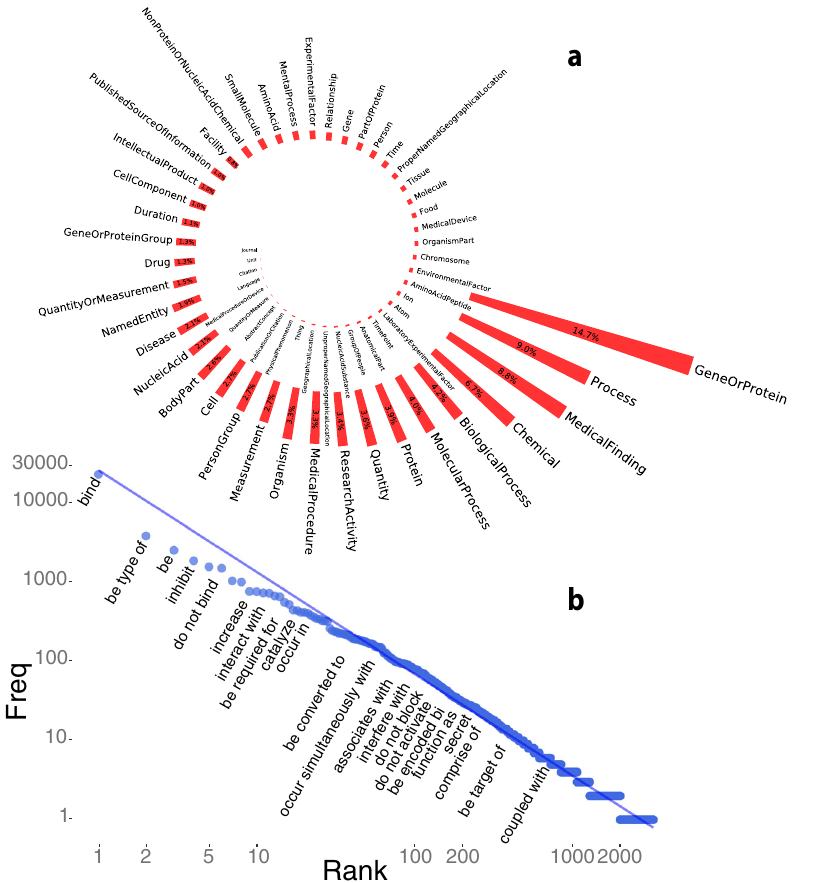
Fig. 2 The relative abundance of annotated named entity classes in our corpus. As is typically the case with human languages, semantic classes are represented unevenly in free texts, following a heavy-tail (Zipf ’ s) distribution. a In biomedical corpora, unsurprisingly, named entities associated with genes and proteins are the most prevalent (15%), followed by processes (9%), medical fi ndings (8.8%), and chemicals (6.7%). At the low-frequency end of the named entity spectrum, we fi nd journal names , units , citations , and languages . b Events connecting two or more entities are also approximately Zipf-law distributed. Event frequencies are closely tracking corresponding named entity classes. For example, the most frequent event, bind , is associated with the most frequently named entity, GeneOrProtein . We tried fi tting the rank-ordered frequency distribution of annotated named entities with a Discrete Generalized Beta Distribution (DGBD). The result showed a signi fi cant deviation from Zipf ’ s law 33 : The observed distribution ’ s tail was not heavy enough to match Zipf ’ s distribution, most likely due to the relatively small number of classes in our ontology 34 . In other words, we expect that frequencies of semantic classes in a very large corpus, annotated with classes from a hypothetical perfect named entity ontology, would follow a Zip fi an (discrete Pareto) distribution of named entity classes. Our action annotations have moved beyond interactions between proteins and genes ( e.g ., bind , inhibit , phosphorylate , encode ), into interactions involving genetic variants and environmental factors ( e.g ., associated with , occur in presence of , trigger , lack ). Ambiguity levels varied broadly across the named entities captured in our corpus. For example, in the class AnatomicalPart , almost all (99.3%) are annotated at the most speci fi c levels, with the majority of entities belonging to BodyPart , CellularComponent , and Cell . In contrast, the general (most vague) concept, Chemical , turns out to be the most annotated within its cluster, although more speci fi c subclasses, such as Protein , NucleicAcid , and Drug are also well represented in the corpus. In the Process concept cluster, about a third of all concept instances are annotated at a more general Process level, and the rest of them are speci fi c concepts, such as MedicalProcedure , MolecularProcess , ResearchActivity , and BiologicalProcess . In addition to these major clusters of concepts, several individual concepts are well represented in the corpus. For example, MedicalFinding represents 7.3% of all entities. Other well-represented concepts include Duration , IntellectualProduct , Measurement , Organism , PersonGroup , PublishedSourceOfInformation , and Quantity . In total, about 70.4% of all entities are annotated at the most speci fi c ontology level. There are fi ve concepts in the NERO ontology that allow the semantic fl exibility needed to avoid arbitrary concept assignment. Entities annotated as AminaoAcidOrPeptide , QuantityOrMeasurement , PublicationOrCitation , MedicalProcedureOrDevice , and GeneOrProtein account for 17.8% of all entities, while less than a quarter (23%) of entities representing either genes or proteins are cleanly annotated with class Gene or class Protein . The remainder are annotated with class GeneOrProtein . In addition to the action bind , actions indicating entities ’ attributes are the next most frequent. Other biological relationships are also well-represented in this annotation, such as inhibit , activate , mediate , interact , contain , and regulate . The top 30 action categories account for 64.4% of all actions annotated with the top ten action categories accounting for 52.2%. Interestingly, negations of actions were also quite abundant in our annotated corpus. For example, do not bind was the sixth most frequent normalized action. Other well-represented negations of actions include do not affect and do not inhibit (see Supplementary Figs. 1 – concepts and almost half of Process instances (49.7%) are annotated are shown in Fig. 2A, B shows the frequencies of relations as more speci fi c sub-concepts; the BiologicalProcess and the represented in the taxonomy. The most frequent text entity type MolecularProcess are the fi fth and seventh most frequent text entity is GeneOrProtein , which accounts for 14.7% of all named entities in types (see Fig. 2). Entity type frequencies follow a heavy-tail the corpus (see Fig. 2A). The second most populous textual entity distribution, with the least frequent types being Journal , Unit , and category is Process , with nine percent tagged. Process has six sub-